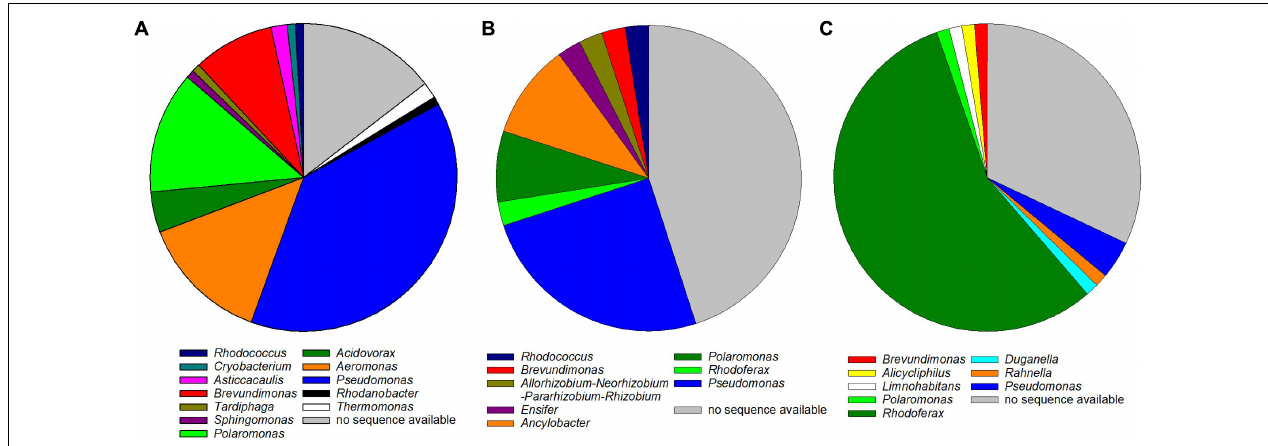
FIGURE 3 | Genus-level classification of arsenic-tolerant (A) , arsenite-oxidizing (B) , and arsenate-respiring (C) microorganisms in the enrichments. The 16S rRNA genes of dominant strains in 117, 45, and 76 enrichments, respectively, were sequenced and classified using the SILVA Alignment, Classification, and Tree service. For some enrichments, no sequence was available because PCR amplification of the 16S rRNA gene was not successful or because the obtained sequence was of low quality.